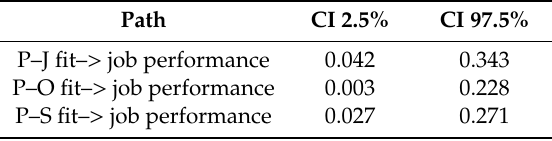
Table 5. Mediating effect of well-being by Bootstrap.